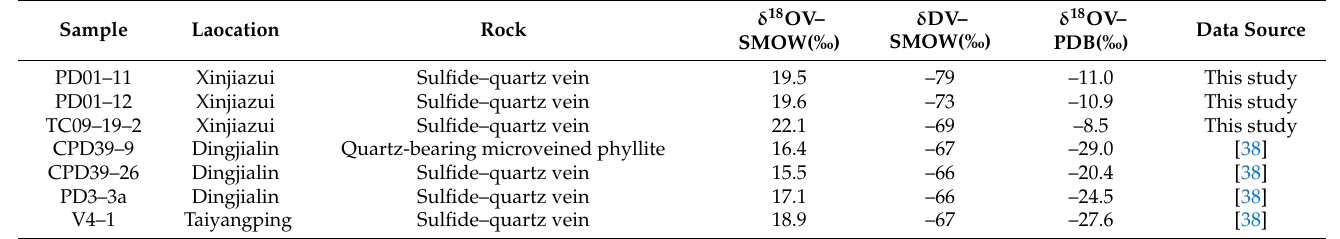
Table 4. Oxygen and hydrogen isotopic composition of quartz from the Xinjiazui, Dingjialin, and Taiyangping gold deposits.